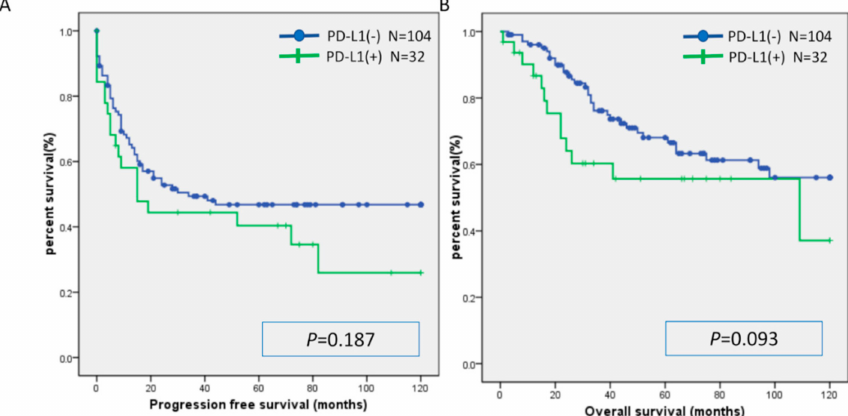
Figure 3. Kaplan-Meier analysis of progression-free survival ( A ) and overall ( B ) survival between the PD-L1( + ) group and PD-L1( − ) group.